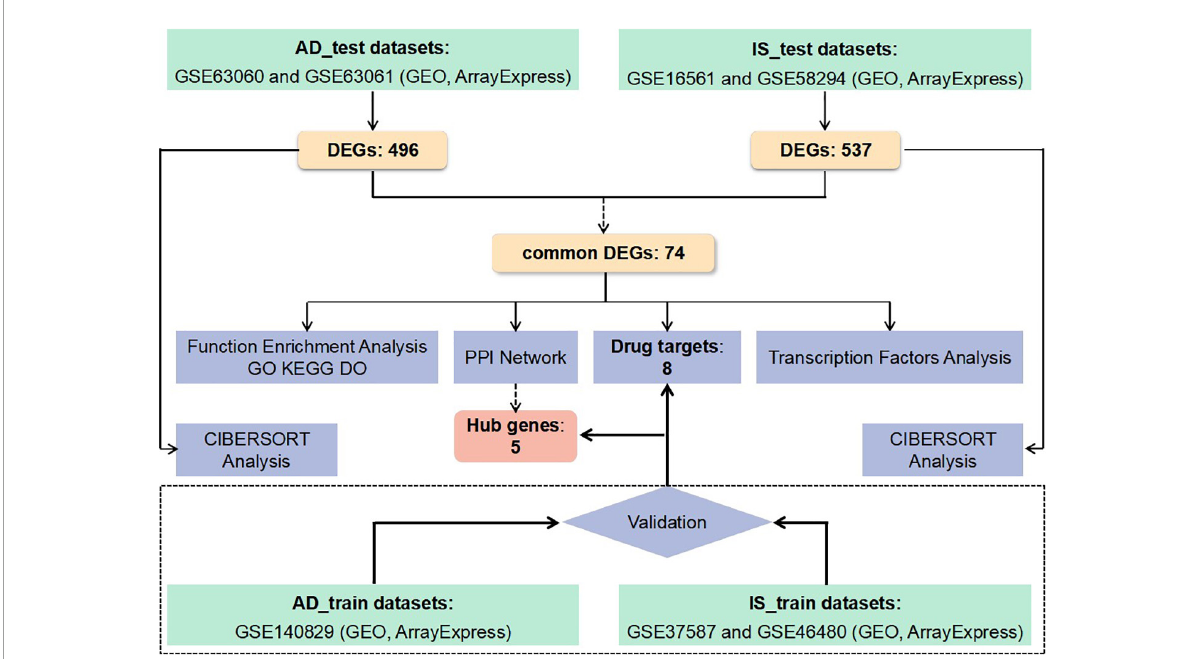
FIGURE1 Flowchart of the study. Microarray data from whole peripheral blood of patients with Alzheimer’s disease (AD) or ischemic stroke (IS) were obtained and analysis for differentially expressed genes (DEGs) between patients and healthy controls was performed. Protein-protein interactions network (PPI–Net), drug targets, functional enrichment, and immune infiltration analysis were applied to common DEGs between AD and IS, to explore shared mechanism between these two diseases. Hub genes obtained by PPI-Net analysis and potential drug targets were validated with test dataset of AD and